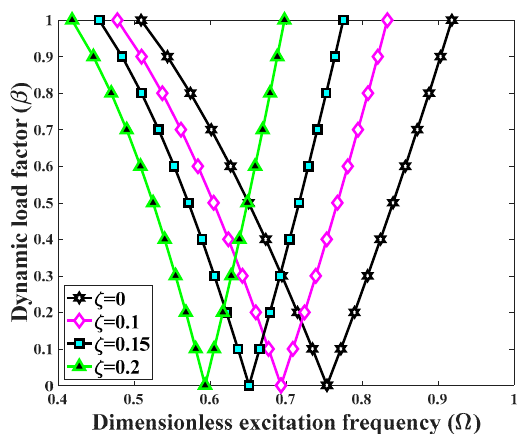
ζ on the DIR for a BD-FG porous cylindrical